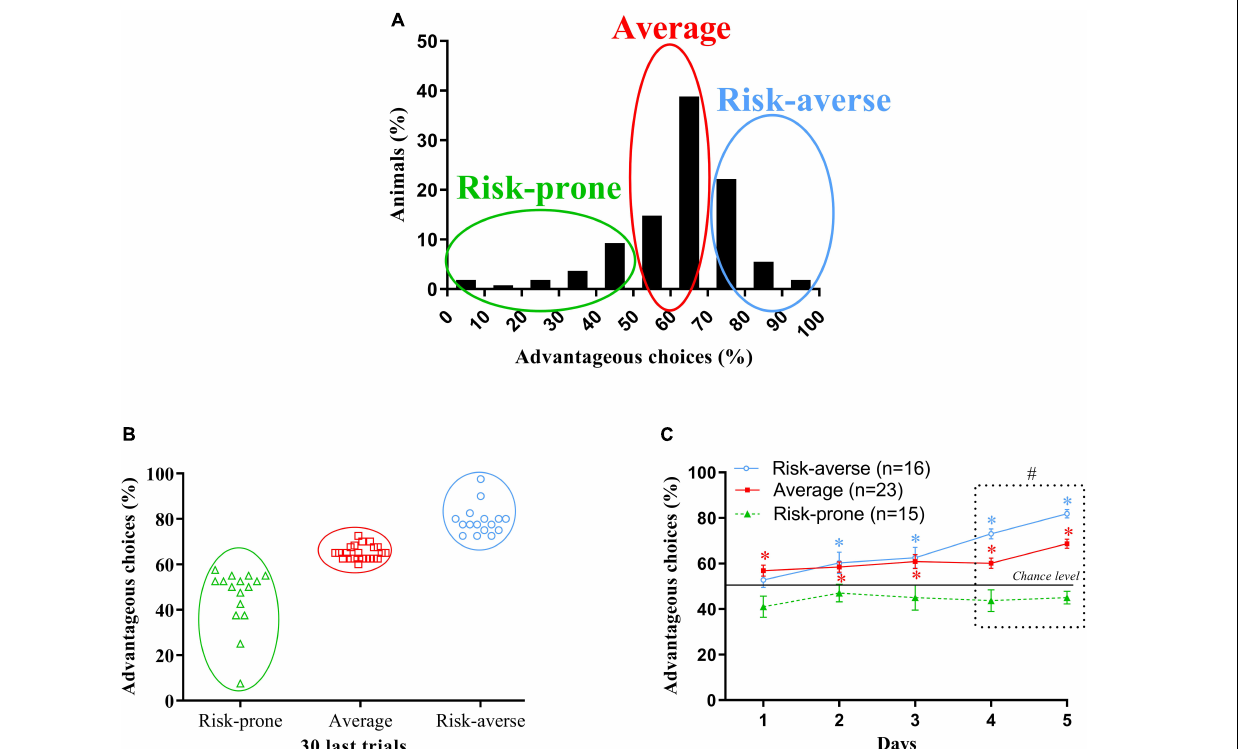
FIGURE 2 | (A) Gaussian repartition of the percentage of animals depending on their preferences during the last 30 trials of the MGT. Risk-prone, average and risk-averse mice are circled. (B) Cluster proposed by the k-mean cluster analysis. Risk-prone, average and risk-averse mice are circled. (C) Evolution of the preferences of the risk-averse, average and risk-prone animals from sessions 1 through 5 in the MGT. ∗ p < 0.05 from the chance level, # p < 0.05 differences from the three subgroups. Adapted from Pittaras E. et al. (2016).